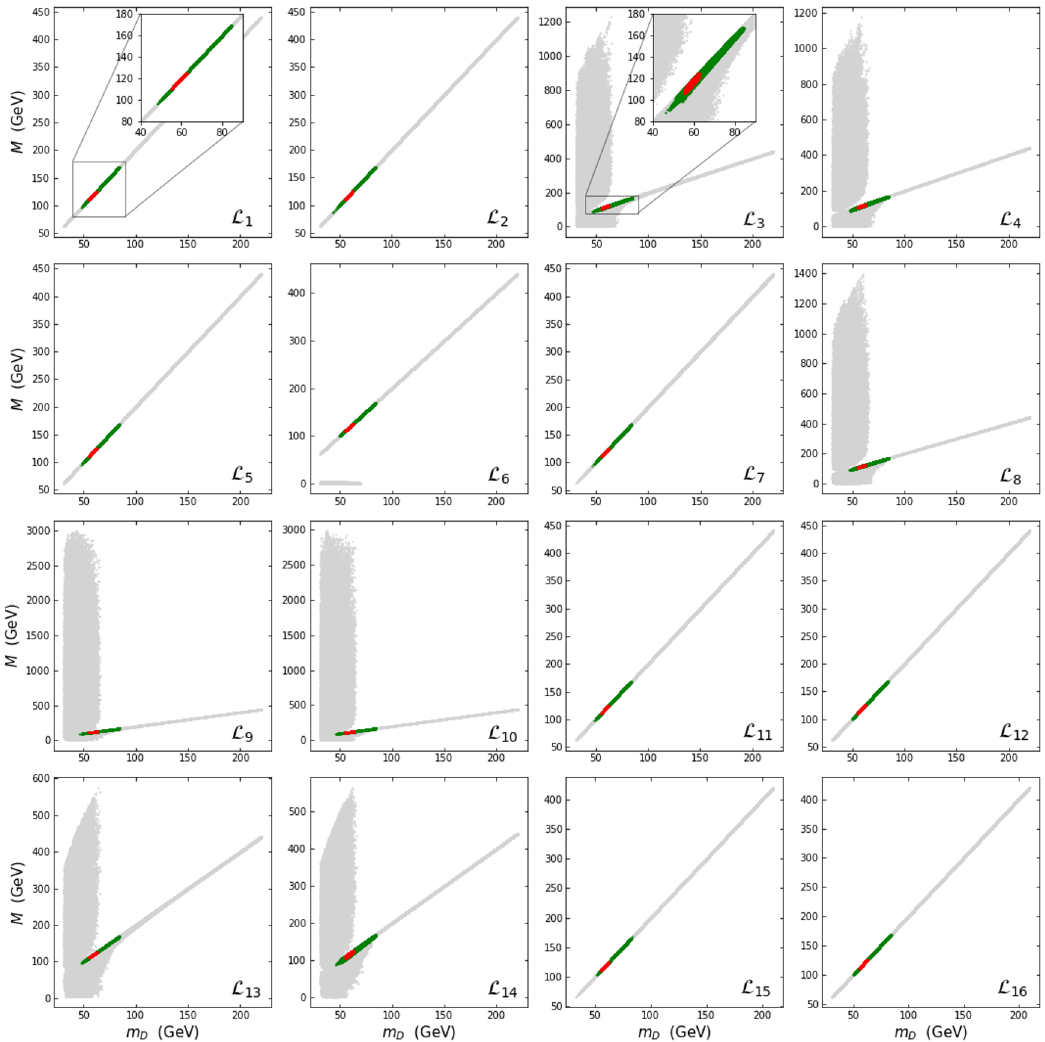
Figure 3 . Samples collected with the conditions: ∆ χ 2 within 2 σ confidence level range, projected on ( m , M ) plane. The red, green, and gray regions correspond to the samples with the original D error bars of GCE residual spectra, the error bars amplified by the square root of the minimum reduced chi-square, and the DM spectra fallen into the gray region in figure 1. At the lower right corner of each sub-figure, we label the model number and its information is given in table